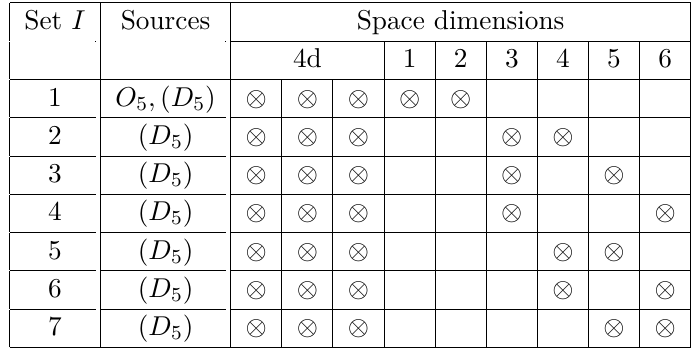
Table 6 . O 5 /D 5 source configuration in the class s 5 . Sources in parentheses are not